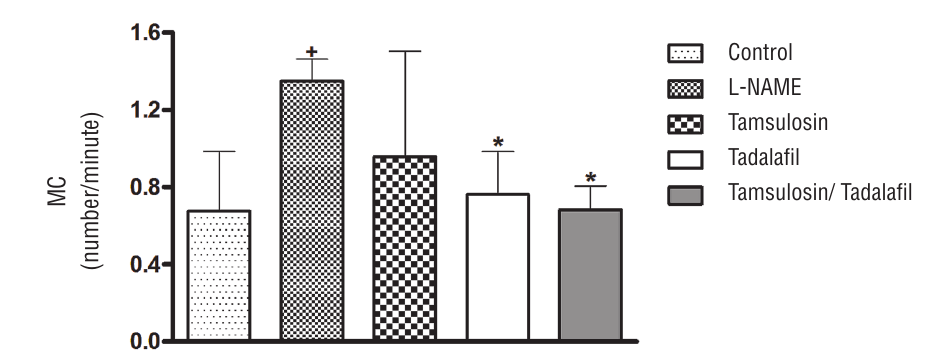
+P < 0.05 comparing L-NAME with control; *P < 0.05 comparing Tadalafil and Tamsulosin/Tadalafil groups with L-NAME. (P refers to Tukey´s multiple comparision test)